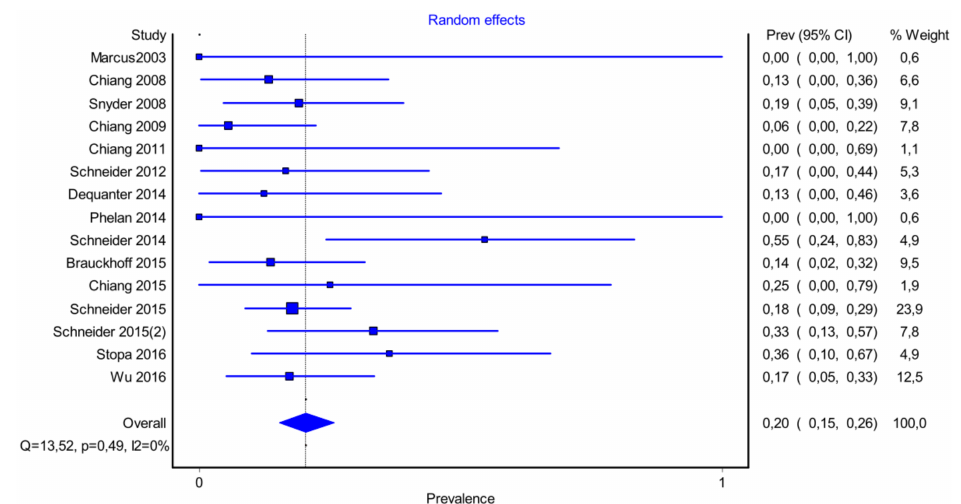
Figure 8. Forest plot P1 (subgroup analysis).